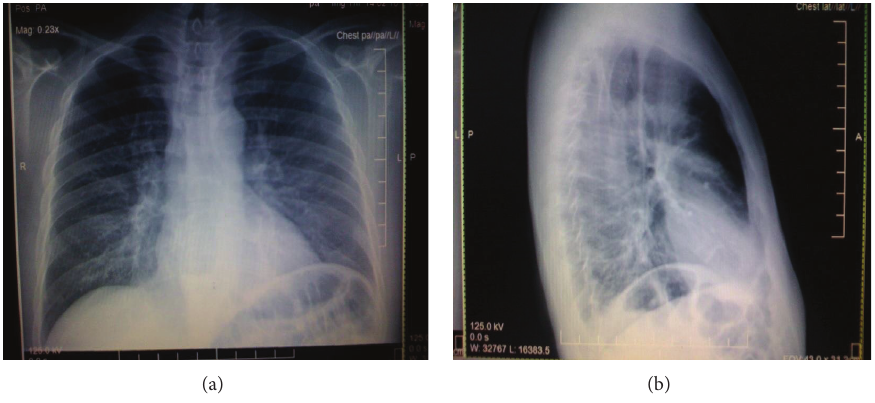
Figure 1: Posterioranterior and lateral chest radiographs showing dilation of the esophagus.